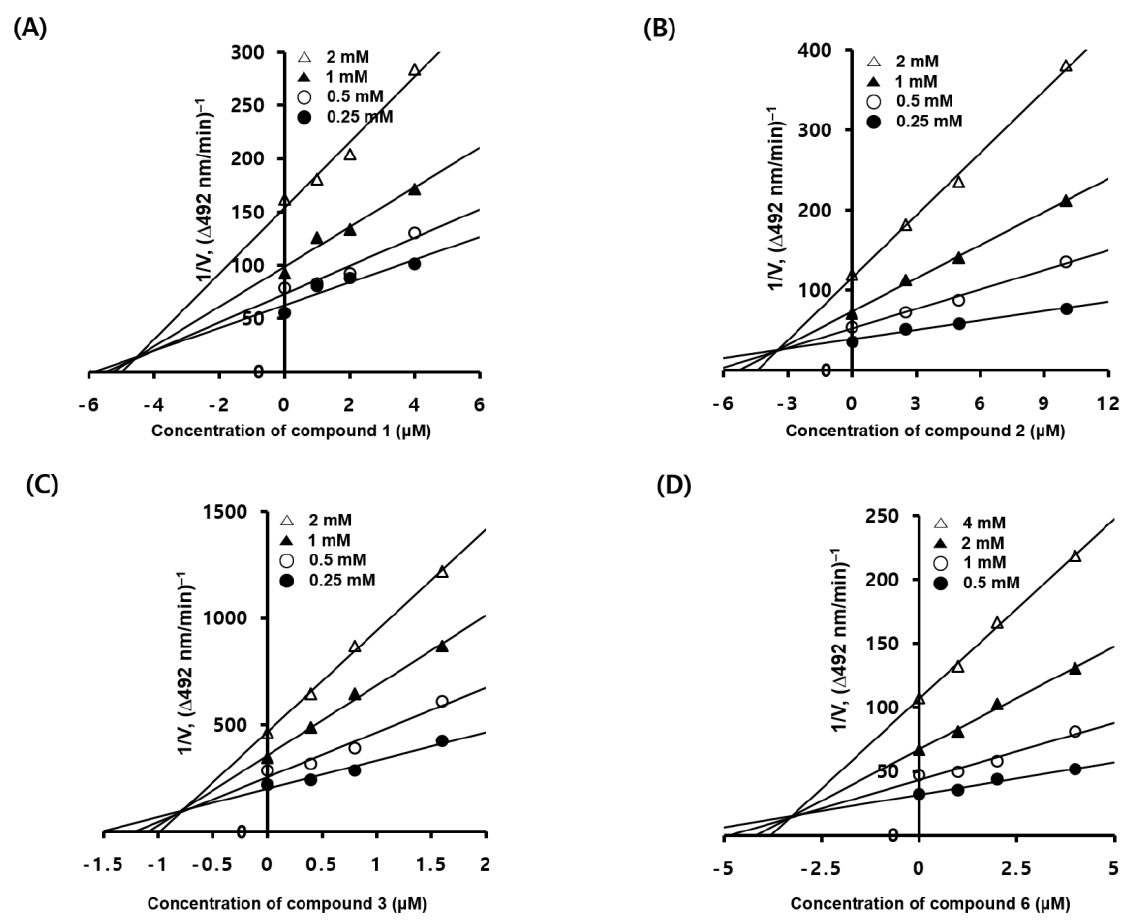
Figure 5. Dixon plots for the inhibition of mushroom tyrosinase by analogs 1 – 3 ( A – C ) and 6 ( D ) using L -DOPA as a substrate. Data are mean 1/V values, defined as the inverse of increased dopachrome absorbance per min at a wavelength of 492 nm, as determined by three independent experiments at four different L -DOPA concentrations (0.25, 0.5, 1, and 2 mM for analogs 1 – 3 and 0.5, 1, 2, and 4 mM for analog 6 ).